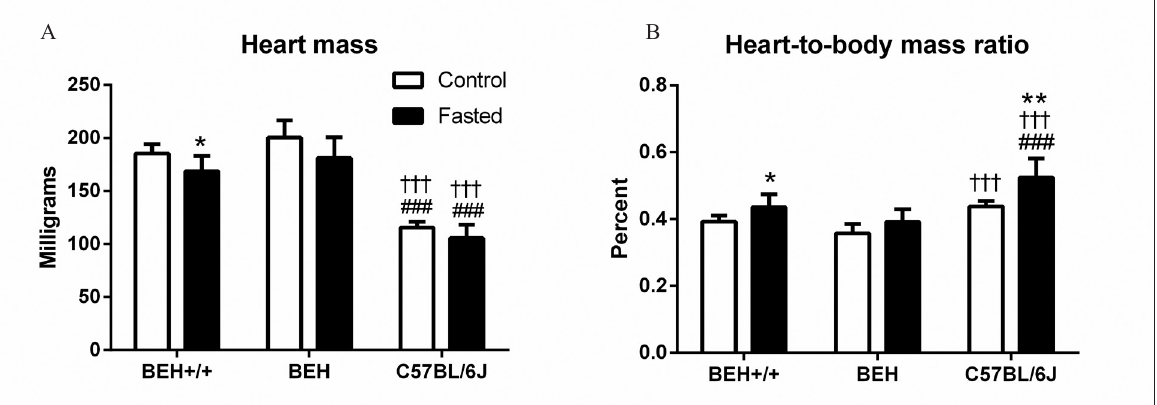
Figure 3. (A) Heart mass and (B) heart mass to body mass ratio in control and fasted mice of BEH+/+, BEH and C57BL/6J strains Note. Values are means ± SD ; * p < .05, ** p < 0.01 vs. control; ### p < .001 vs. BEH+/+; ††† p < .001 vs.